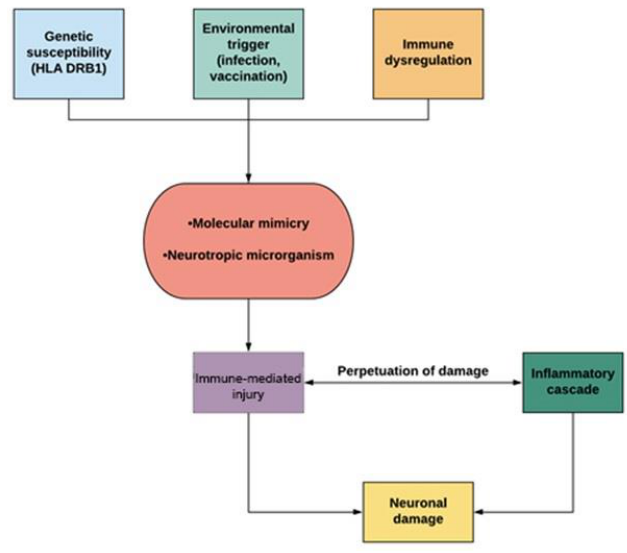
Figure 1. Pathogenesis of acute disseminated encephalomyelitis (ADEM). Immune-mediated injury consists predominantly of demyelinating lesions of the